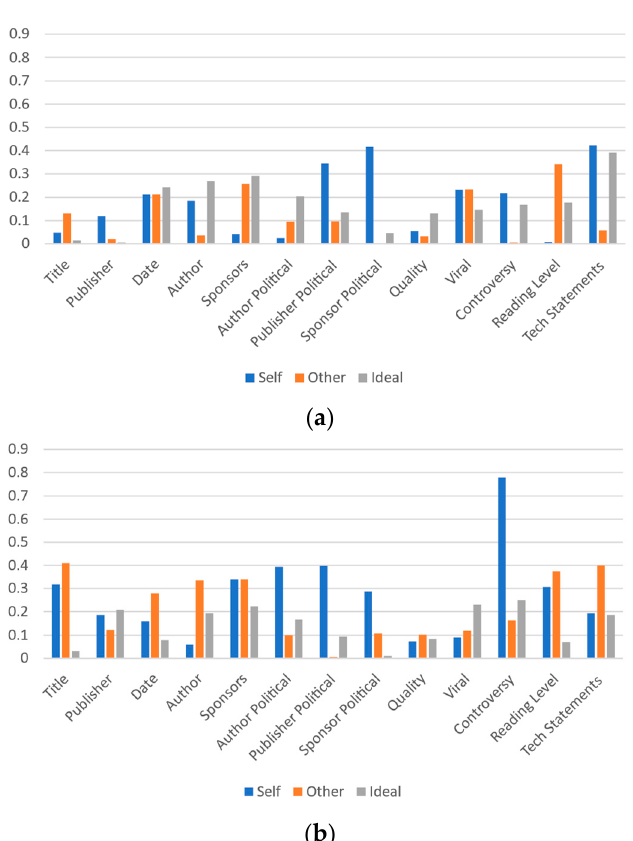
Figure 12. Differences in responses for each category’s effect on perception of trustworthiness or credibility between: ( a ) University A and University B and ( b ) 18–29 and 30+ age groups. Differences are based on mean values of participant responses for each article label metric with values of 0 to 4 where 0 is “none at all” and 4 is “a great deal”. Note the axis range is from 0 to 0.9 on these figures for readability.